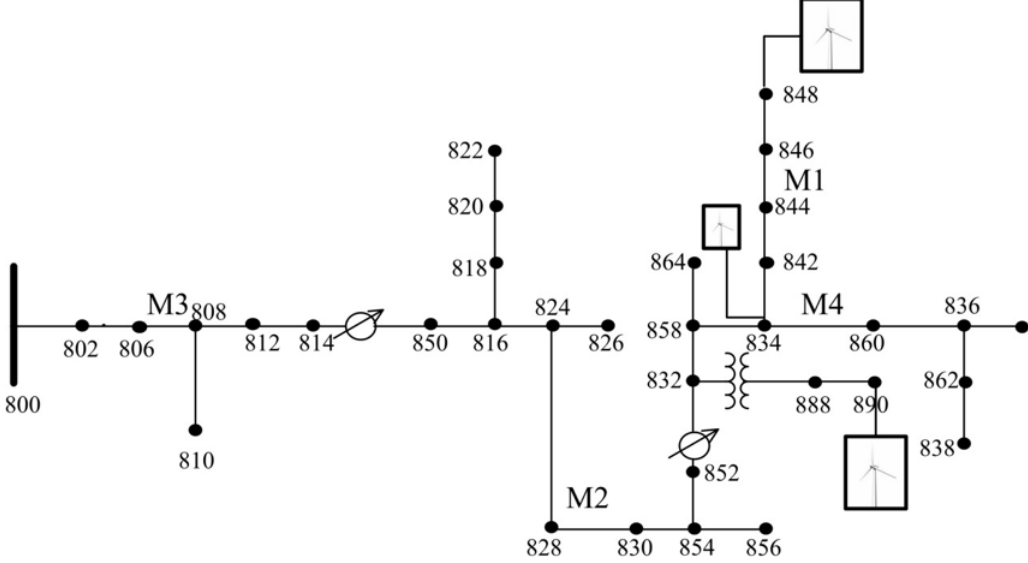
Figure 5. IEEE 34-Node Test Feeder System after the addition of Three WGs.